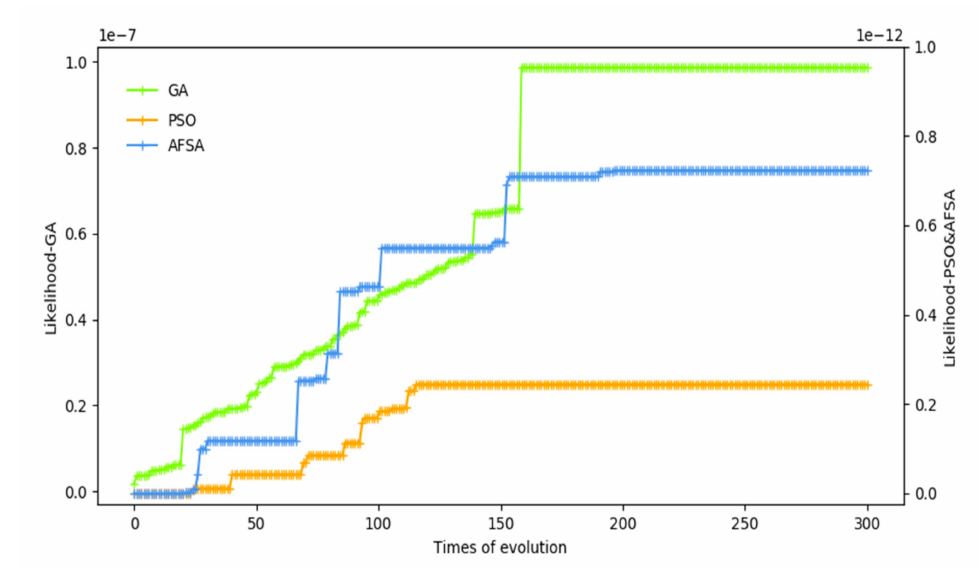
Figure 6. The optimal values of fitting in the four states were 20, 15, 19, and 17 respectively, and the detailed polynomial regression coefficients are given in Table 7.